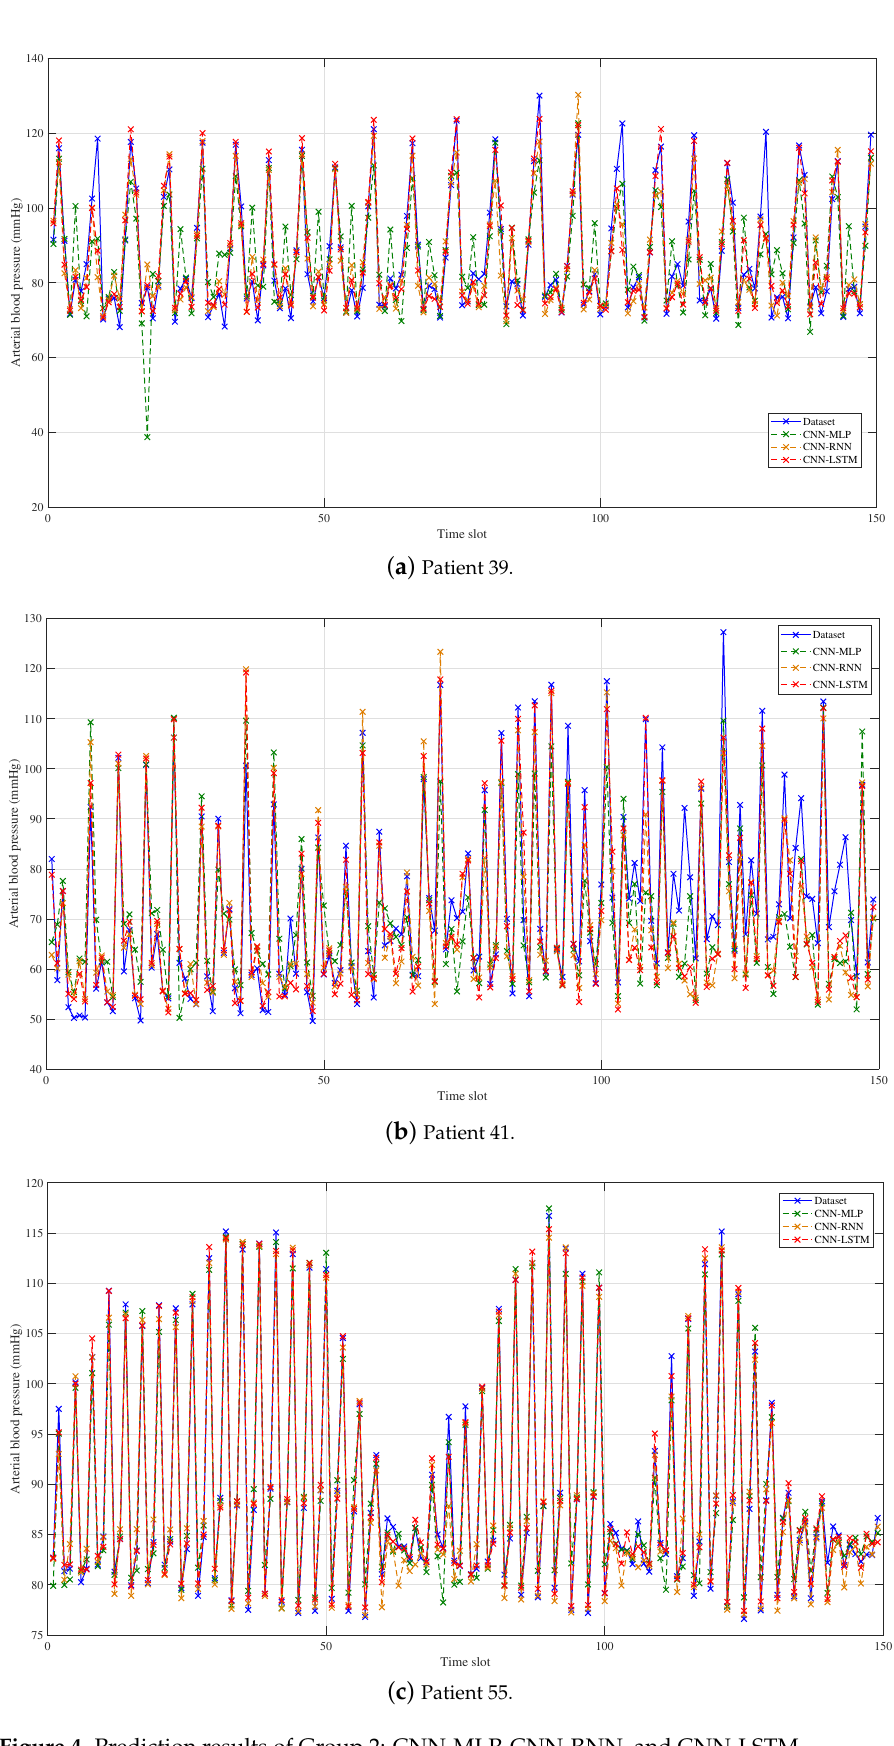
Figure 4. Prediction results of Group 2: CNN-MLP, CNN-RNN, and